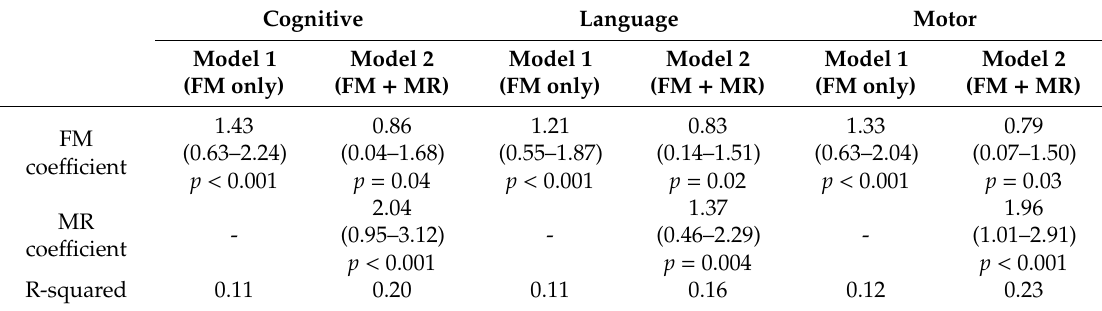
Table 2. Comparison of the extent to which the fidgety movement (FM) score or the motor optimality score (FM plus motor repertoire (MR) scores) better accounts for the variance in infants’ scores on Bayley III subscales of infant development, using linear regression models. Values are the beta coe ffi cients of the independent variables of the regression equations with 95% confidence intervals in